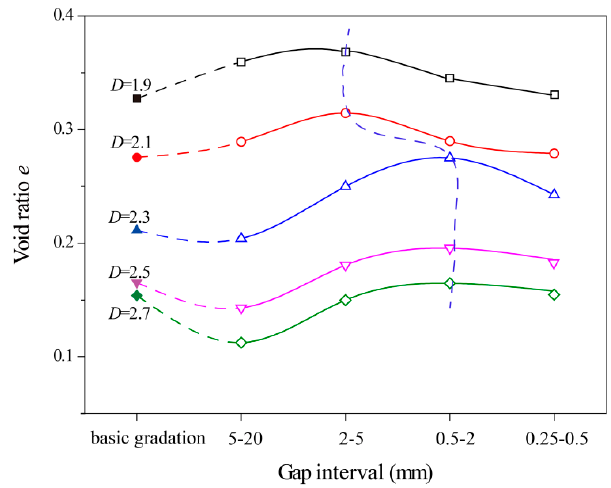
Figure 5. Void ratios of the SRMs with gap intervals under different basic gradations.